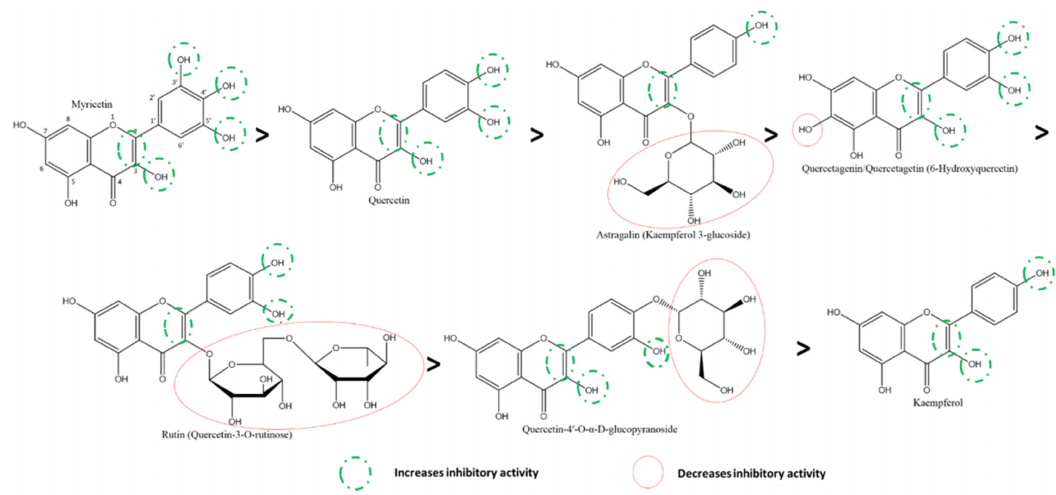
Figure 9. Structure–activity relationships of various flavonols against SARS-CoV-2 3CLpro, adapted from the experiments of [118] using cell-free based in vitro FRET assays. Substitutions and groups that result in an increase/decrease in inhibitory activities are shown in red and green,